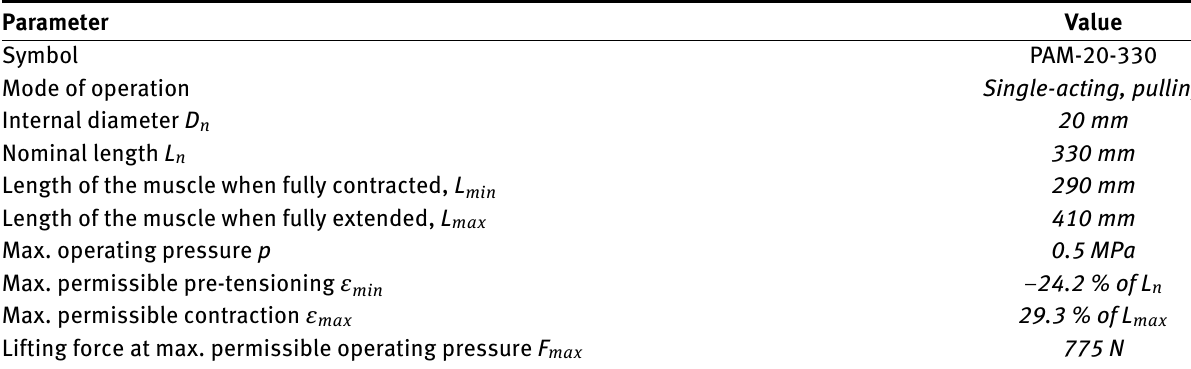
Table 1: Parameters of pneumatic artificial muscle PAM-20-330.